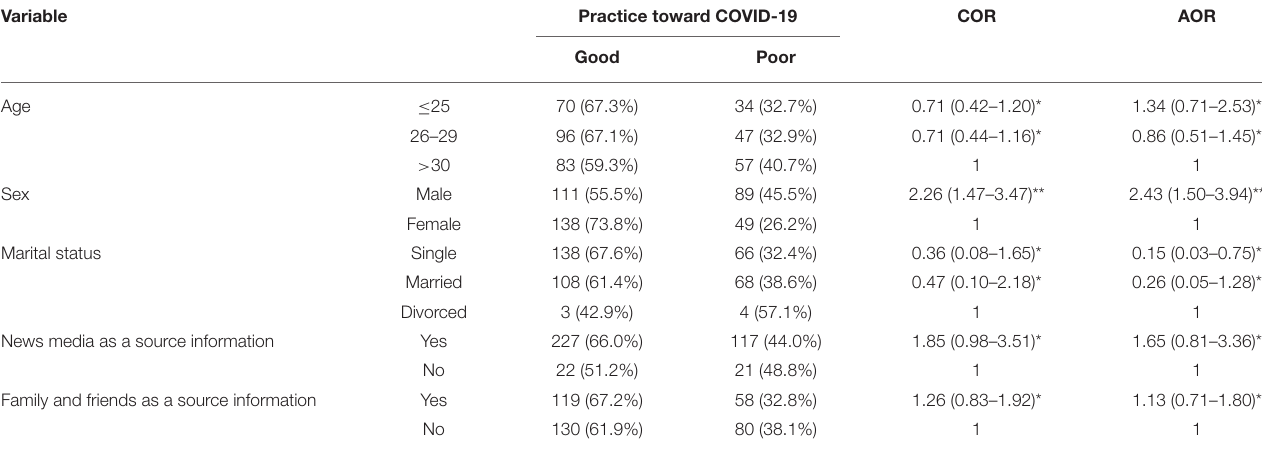
TABLE 4 | Univariate and multivariate logistic regression analyses showing predictors of practice to prevent COVID-19 among health workers at Aksum University Comprehensive and Specialized Hospital (AKUCSH) and Saint Mary’s General Hospital in Tigray Regional State of Northern Ethiopia ( n = 403), April to May 2020.